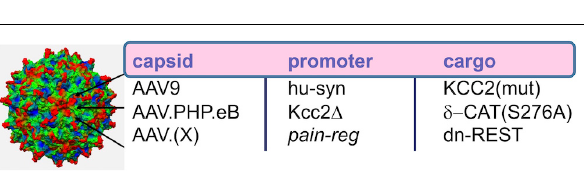
FIGURE 4 | Spinal cord dorsal horn pain relay neuron, site of action of Kcc2 gene expression-enhancing treatments: possible synergies with other analgesic treatments.